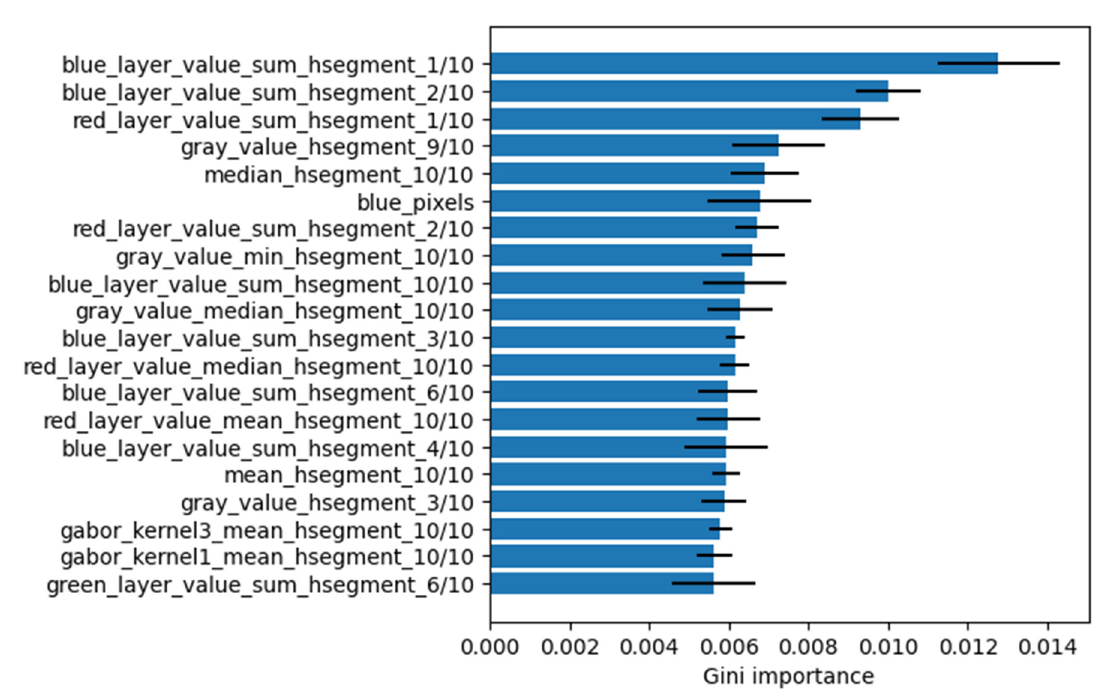
Figure 3. Top 20 most important features extracted from trained Random Forest model, sorted by Gini importance. The names of the features are explained in more detail in the supplement Table S1.